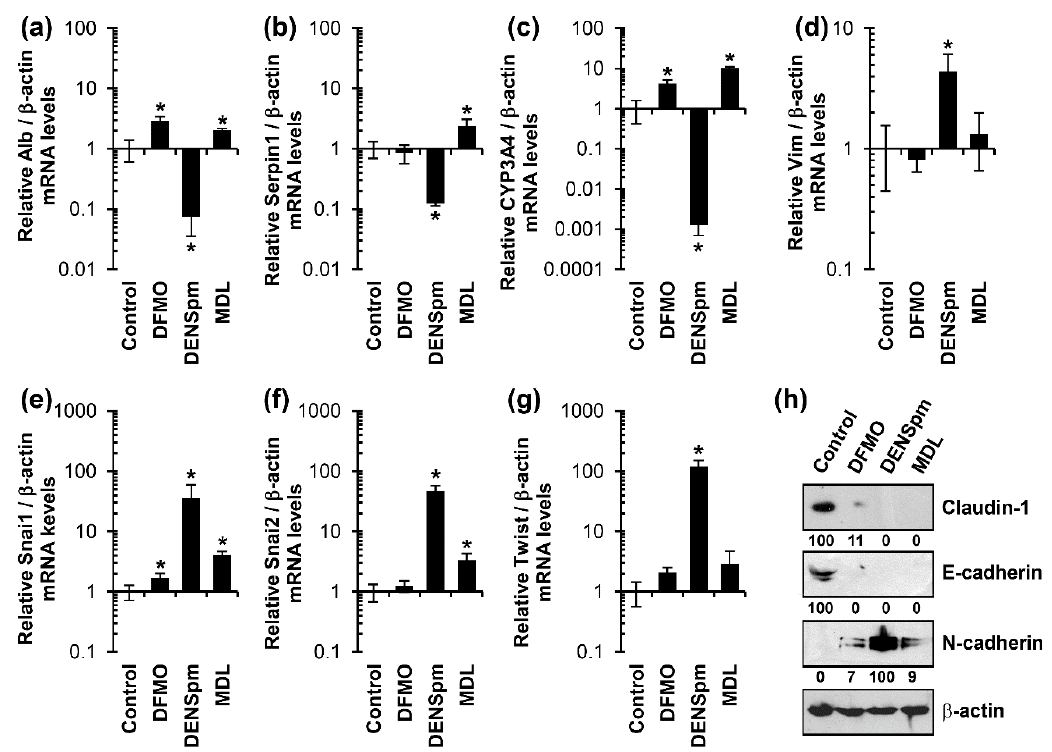
Figure 3. Diethyl-nor-spermine causes a decrease in expression of hepatocyte-specific genes and an increase in expression of mesenchymal cell-specific genes in hepatic epithelial HepaRG cells. Differentiated HepaRG cells were treated for 72 h with 5 mM DFMO, 10 μ M DENSpm, or 25 μ M MDL72.527 (denoted on the figure as MDL). ( a – g ) Quantification of levels of mRNAs for liver epithelial and mesenchymal cells were performed as described above. The results are presented as means ± S.D. from three independent experiments. * p < 0.05 vs. untreated cells (Control). ( h ) Expression of epithelial (claudin-1, E-cadherin) and mesenchymal (N-cadherin)—specific genes was quantified by western blotting, using β -actin as a house-keeping gene. The values represent protein/ β -actin levels normalized to the control (%) with the exception of N-cadherin.